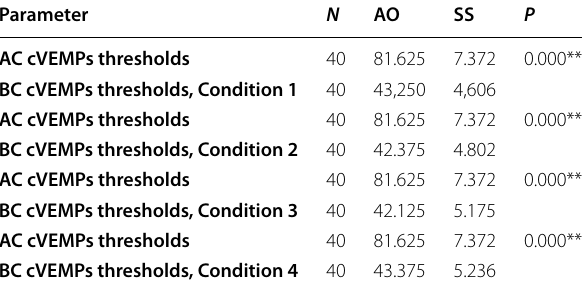
Table 5 Comparison of AC cVEMPs and BC cVEMPs